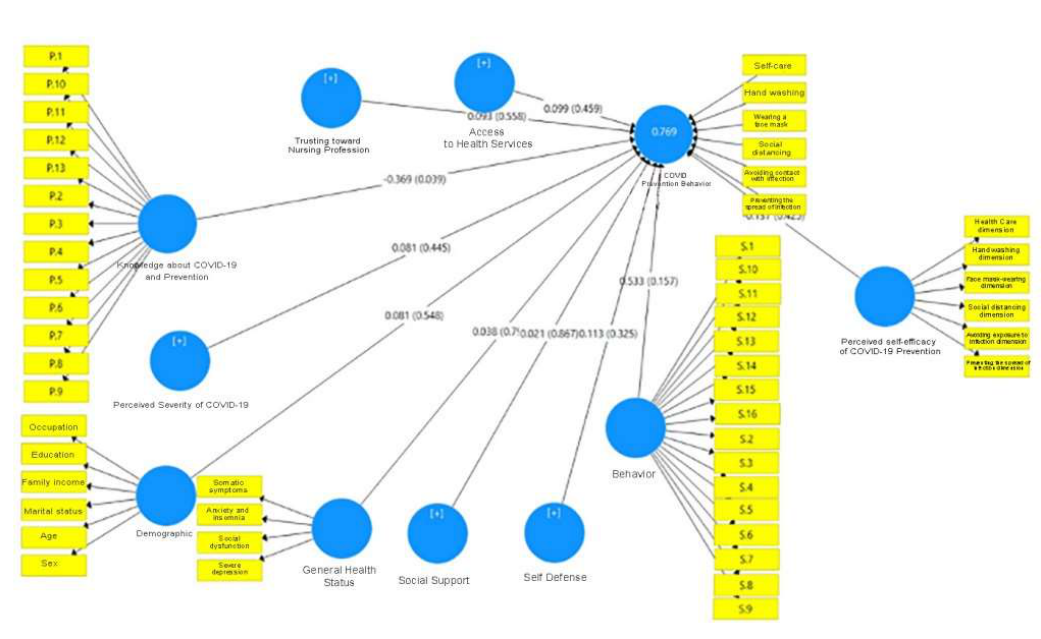
Fig. 1. Path analysis for PLS : Output Results Older Adults Group